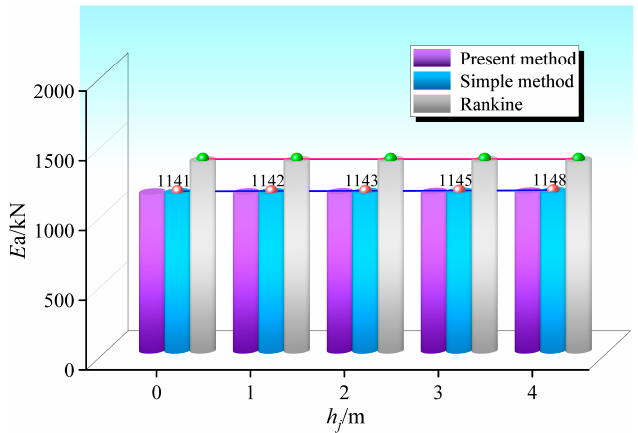
Figure 18. The influence of overlying soil thickness.